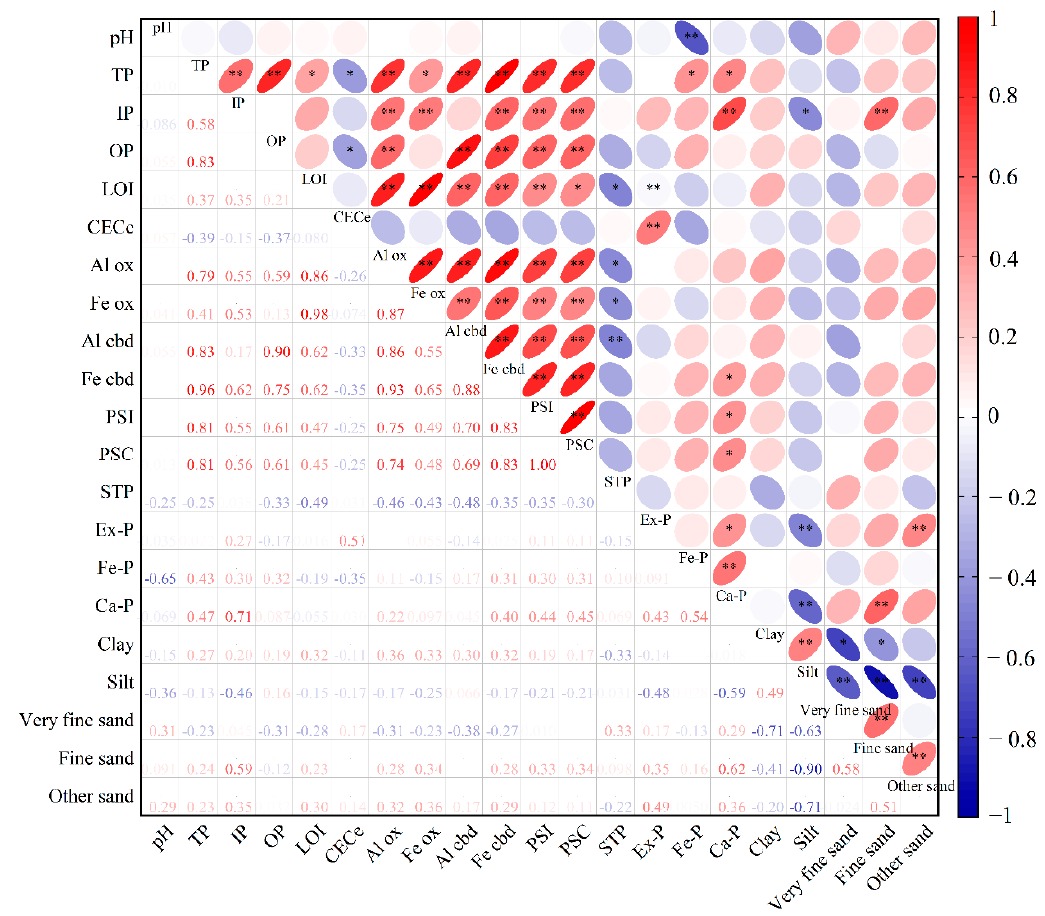
Figure 4. Correlation analysis among variables in the YQ 2–5 sediment cores. * Correlation is significant at p < 0.05; ** Correlation is significant at p < 0.01.